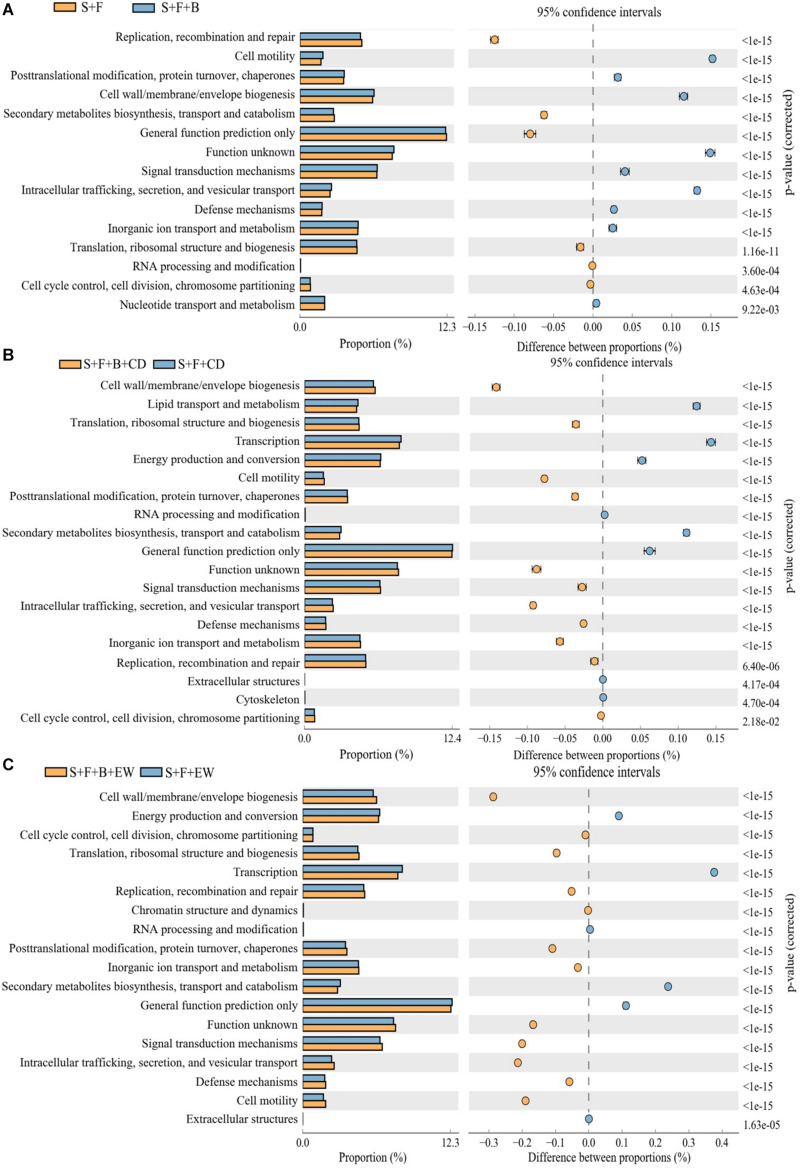
The cluster of orthologous groups (COG) categories differed significantly between treatments. “S + B” and “S + B + C” treatments (A), “S + F + B + CD” and “S + F + CD” (B), and “S + F + B + EW” and “S + F + EW” (C). Values are the mean ± SD of three replicates. S, healthy control (healthy soil); S + F, disease control (healthy soil + FOC4); S + F + B, healthy soil + FOC4 + HN03 treatment; S + F + B + EW, healthy soil + FOC4 + HN03 + wormcast treatment; S + F + EW, healthy soil + FOC4 + wormcast treatment; S + F + B + CD, healthy soil + FOC4 + HN03 + cow dung compost treatment; S + F + CD, healthy soil + FOC4 + cow dung compost treatment. Bars sharing the same letter are not significantly different on the basis of Tukey’s test at P < 0.05.